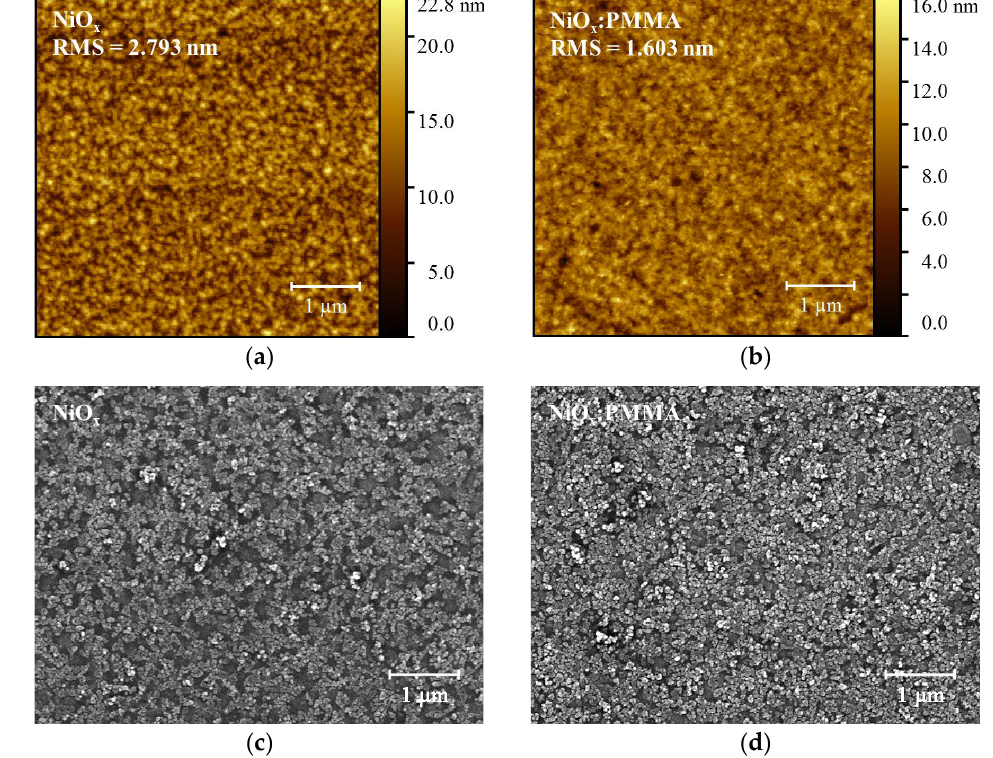
Figure 6. ( a ) Atomic force microscopy (AFM) height image of NiO x HTL film. ( b ) AFM height im- age of NiO x :PMMA HTL film. ( c ) Top-view scanning electron microscopy (SEM) image of NiO x HTL film. ( d ) Top-view SEM image of NiO x :PMMA HTL film.